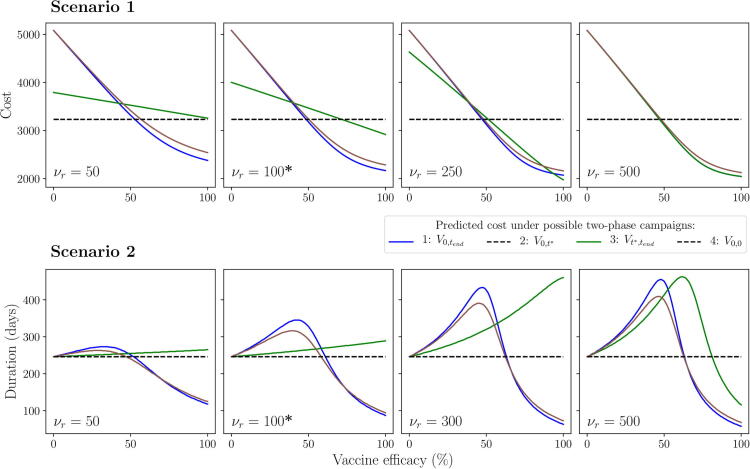
Effect of the daily vaccine rate on campaign performance - Scenarios 1 and 2. All other parameters are fixed to the values given in Table A.2. Asterisks identify the default value for the daily rate used in each scenario.